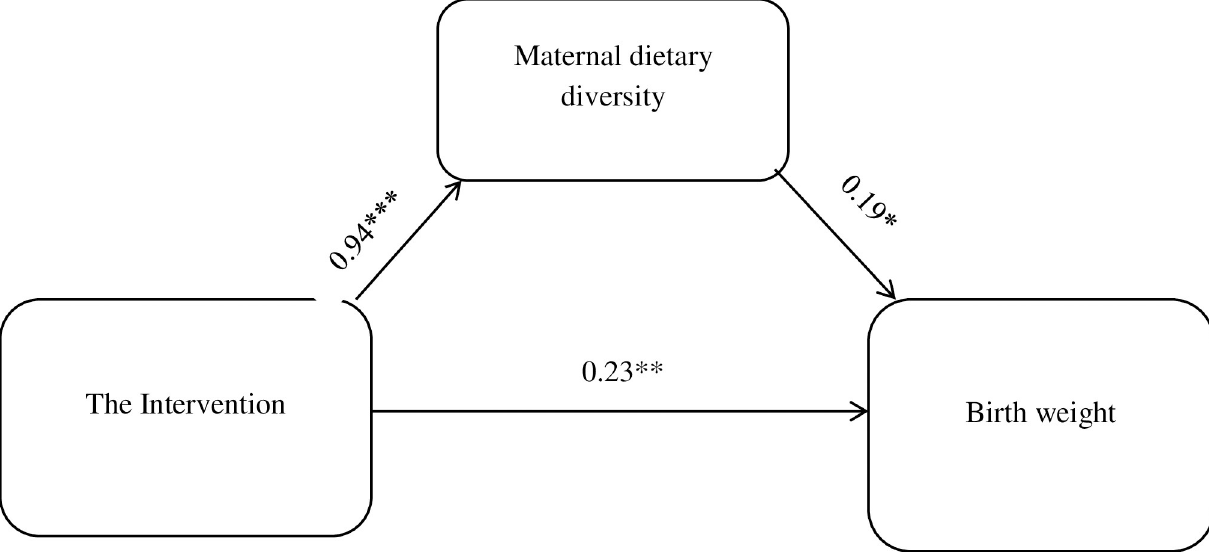
Fig 3. The indirect effect of nutrition education intervention through male involvement on birth weight, Ilu Aba Bor, zone southwest Ethiopia, 2019/20. Note: ��� p < 0.001, �� p < 0.01, � p <